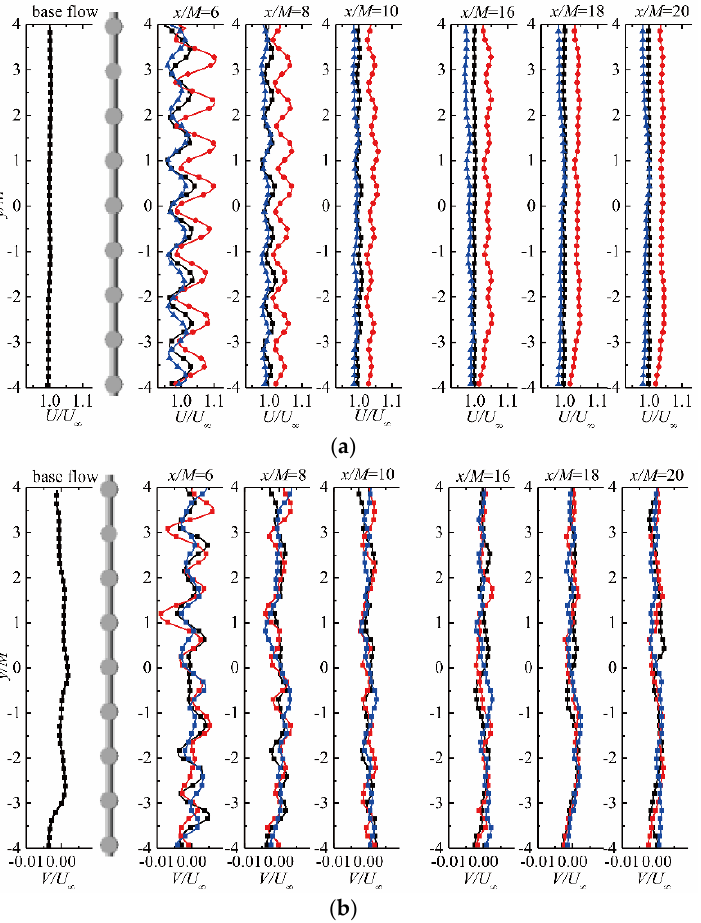
Figure 2. Horizontal distribution of mean velocities ( a ) stream-wise components ( U / U ∞ ); ( b ) trans- verse components ( V / U ∞ ); red (1/3 depth), black (mid-depth), blue (2/3 depth).